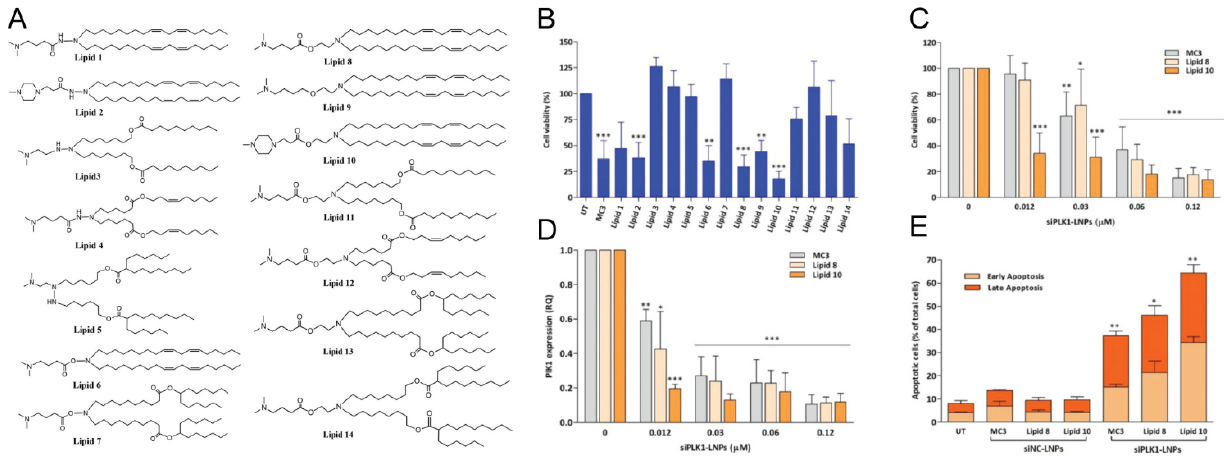
Figure 3. ( A ) Chemical structures of the synthesized new lipids. ( B ) The effect of LNPs-siPLK1 on cell viability. ( C ) The effect of MC3, lipid-8-or lipid-10-based LNPs-siPLK1 on cell viability. ( D ) PLK1 mRNA levels after MC3, lipid-8- or lipid-10-based LNPs-siPLK1 treatment. ( E ) Cell apoptosis analysis after MC3, lipid-8- or lipid-10-based LNPs-siPLK1 treatment. * p < 0.05; ** p < 0.001; *** p < 0.0001. Reprinted with permission from [78]. Copyright 2020 Wiley-VCH.